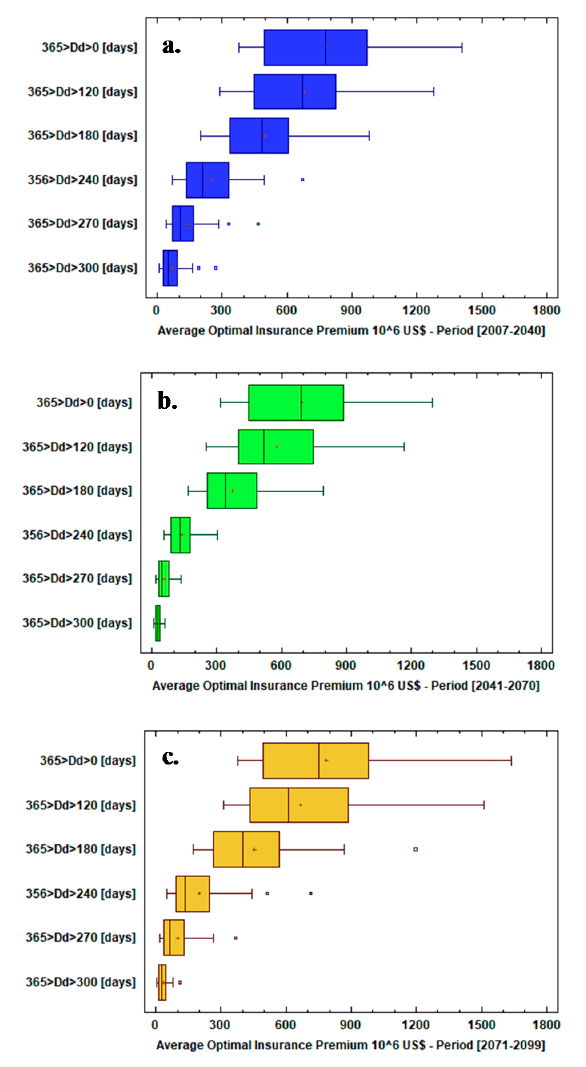
Figure 6. Average (dots) and range (boxplots) of actuarially fair premiums per drought duration coverage at each regional climate model (RCM) output time period: ( a ) 2007–2040, ( b ) 2041–2070, and ( c ) 2071–2099 while considering the set of change drivers (climate, demand, and frequency; each boxplot comprises 2400 data